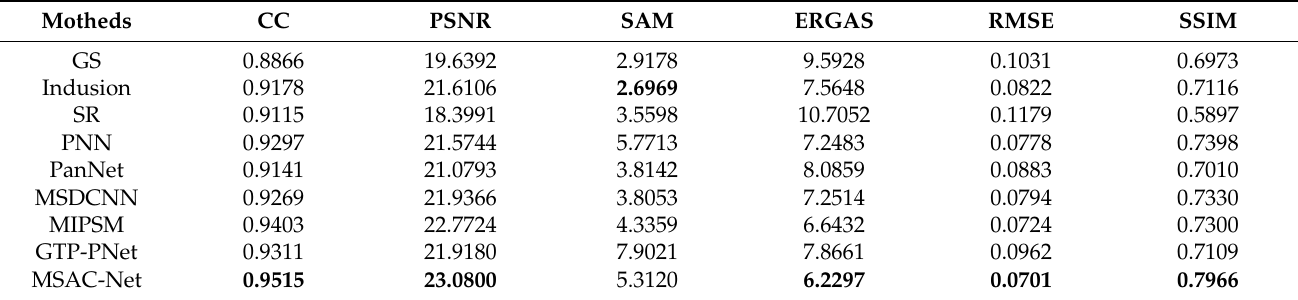
Table 8. Quality metrics of the different methods on the simulated QuickBird